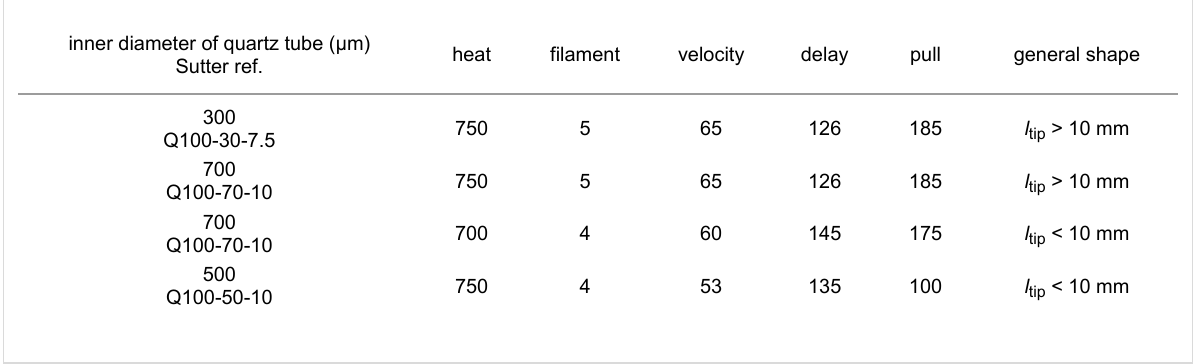
Table 2: Puller programs with the obtained general shapes and hole diameters d tip < 100 nm.